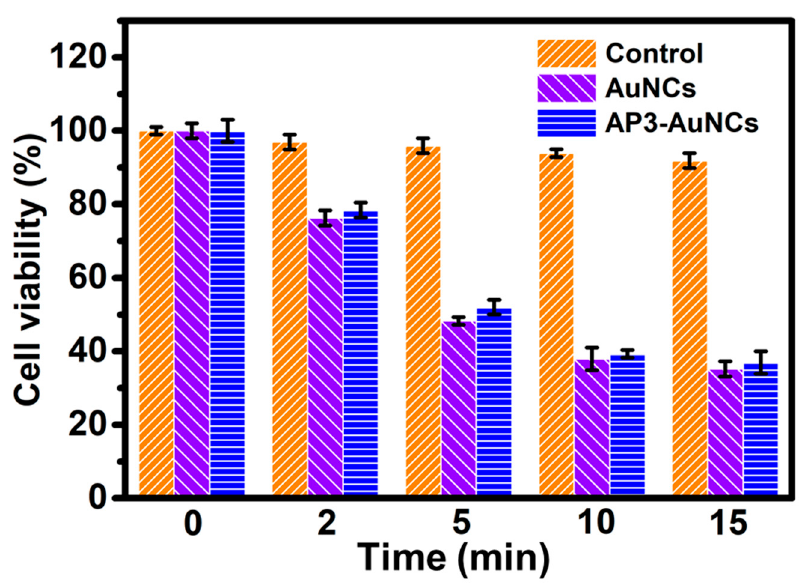
Figure 7. In vitro cell viability for AP3-AuNCs and AuNCs post 24 h incubation induced by PTT. For PTT effect, the cells were irradiated under 808 nm diode laser (1 W/cm 2 ) for 2, 5, 10, and 15 min. Data are expressed as mean ± SD, n = 3.